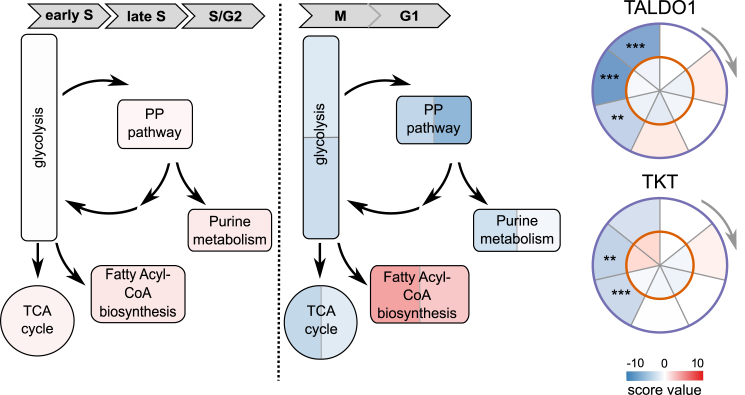
Metabolic PathwaysCell-cycle effect on the stability of protein components of the pentose phosphate pathway (PPP). On the left-hand side, the PPP is shown along with related pathways colored by average stability across the stages from early S to S/G2. On the right-hand side, the same constellation is shown. It is colored in stability values derived from mitosis (left) and G1 phase (right) for each protein. TKT and TALDO1 are two enzymes of the PPP that become significantly destabilized upon the onset of mitosis.See also Figure S3 and Table S2.